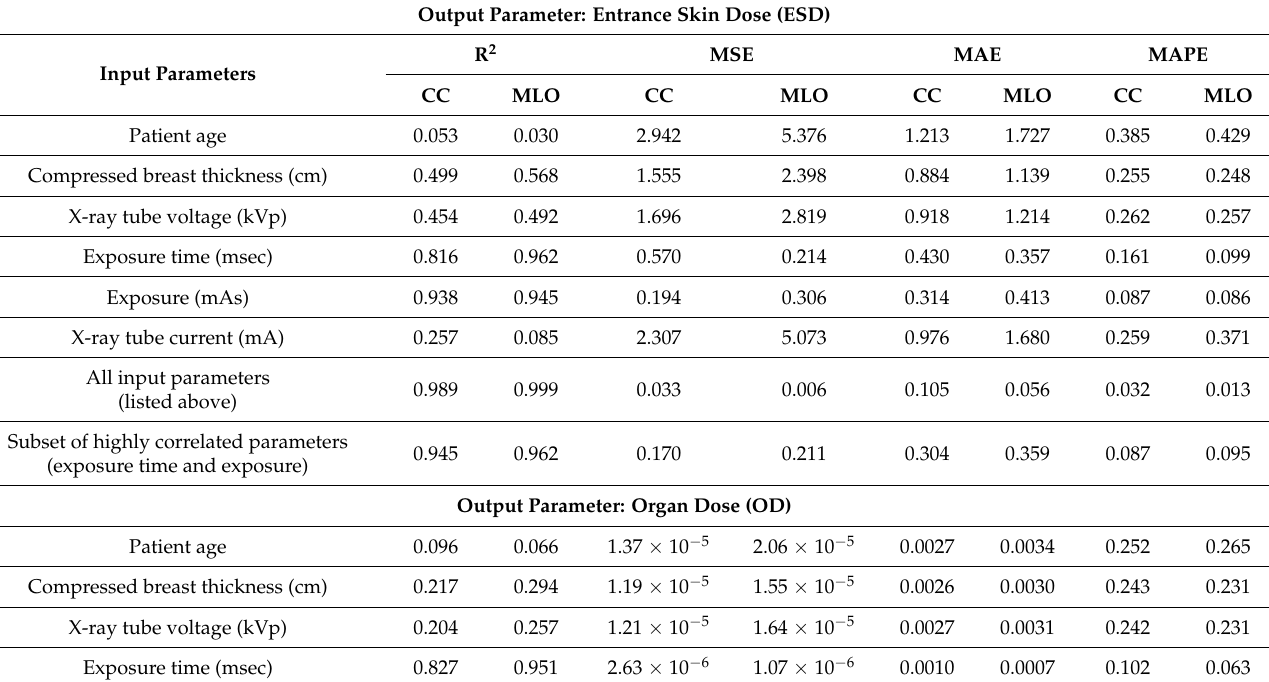
Table 4. Evaluation of regression analyses between patient age, compressed breast thickness, and acquisition parameters as input parameters and entrance skin dose (ESD), organ dose (OD), and mean glandular dose (MGD) as output parameters for each